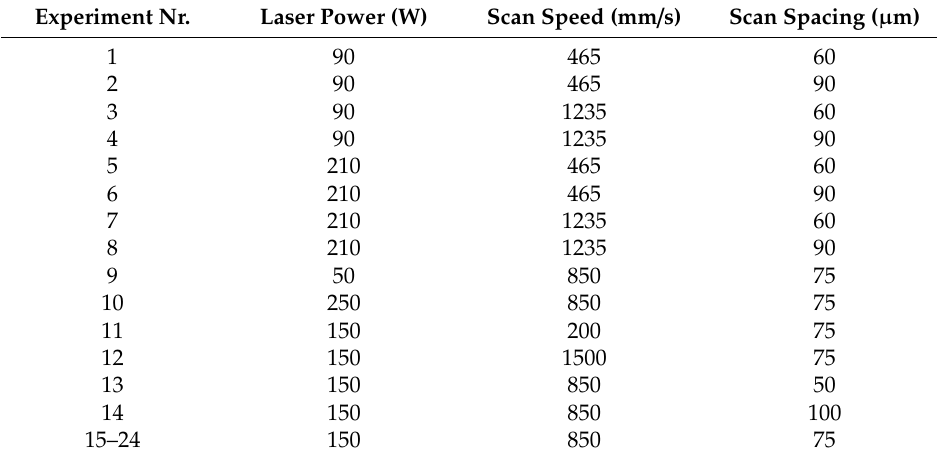
Table 2. Design of Experiments (DoE) for experimental trials.